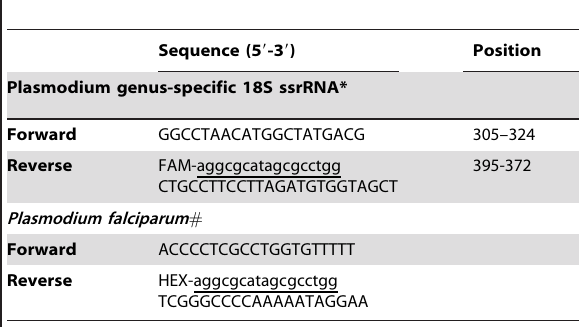
Table 1. Oligonucleotide primer sequences used in the real- time PET-PCR